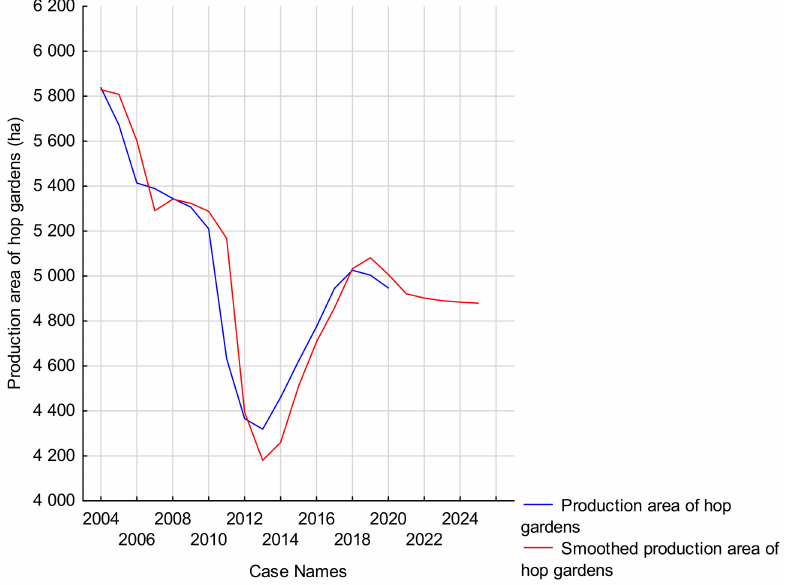
Figure 2. Area development and prediction of production hop fields in the years 2004–2024 in Czechia (in ha)